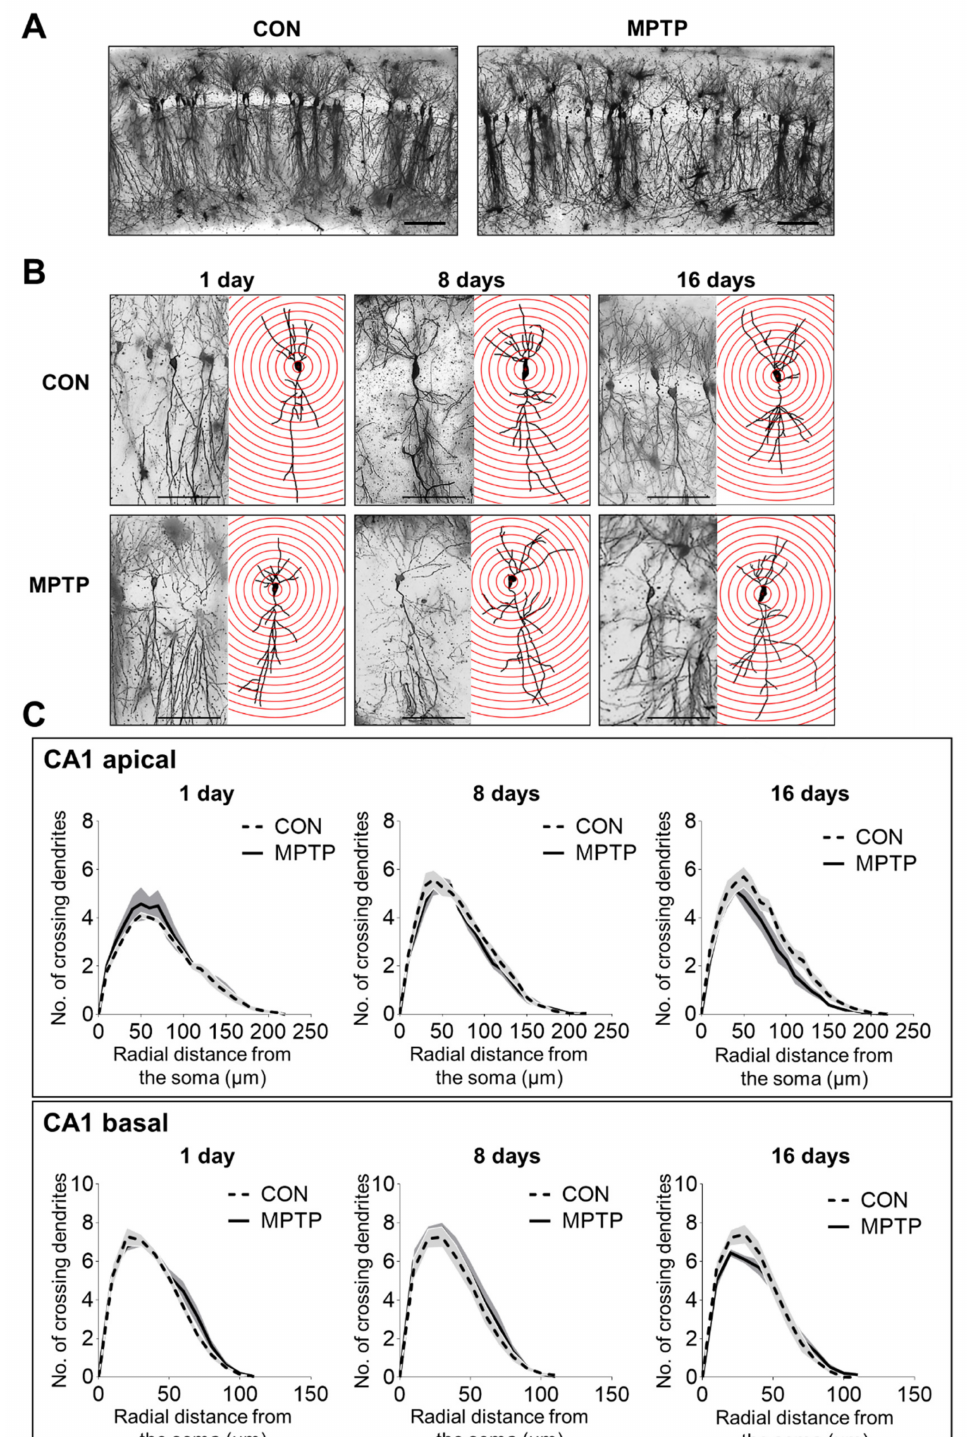
Figure 2. Golgi staining revealed the dendritic arborization of the hippocampal cornu ammonis 1 (CA1) subregion following acute MPTP treatment. ( A ) Representative images of CA1 subregion of control (CON) and MPTP-treated group at lower magnification. ( B ) Representative images of CA1 pyramidal neurons from the CON and MPTP-treated groups at 1, 8, and 16 days after injection at higher magnification. ( C ) Line graphs show the number of intersections per 10 µ m radial unit distance from the soma in apical (upper panel) and basal (lower panel) dendrites at 1, 8, and 16 days after injection. Data are expressed as the mean ± standard error ( n = 6 mice/group). The scale bars in A and B represent 200 µ m and 50 µ m,